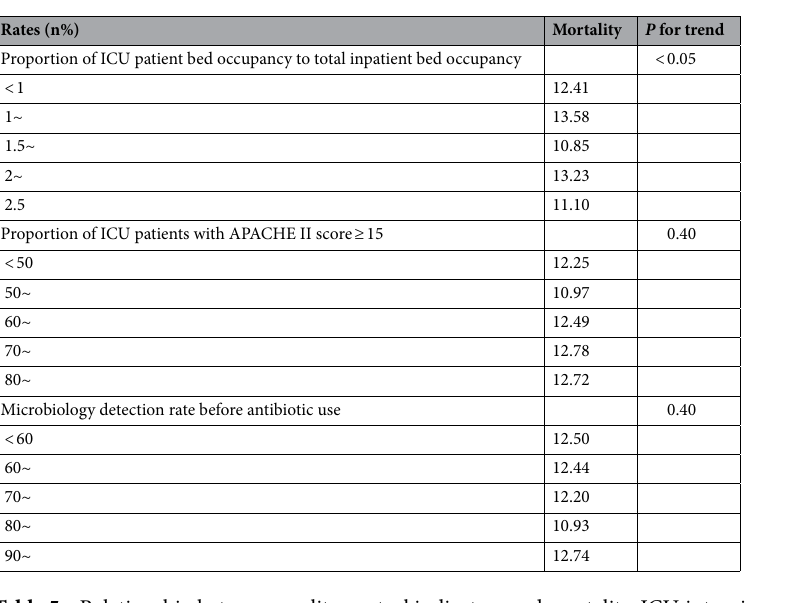
Table 5. Relationship between quality control indicators and mortality. ICU, intensive care unit; APACHE, acute physiology and chronic health evaluation.